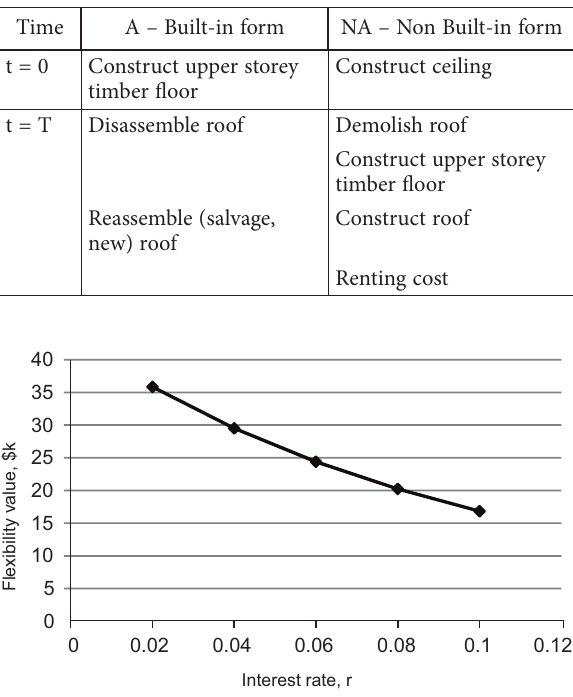
Figure 1. Case example – change in flexibility value with interest rate (per annum). T =